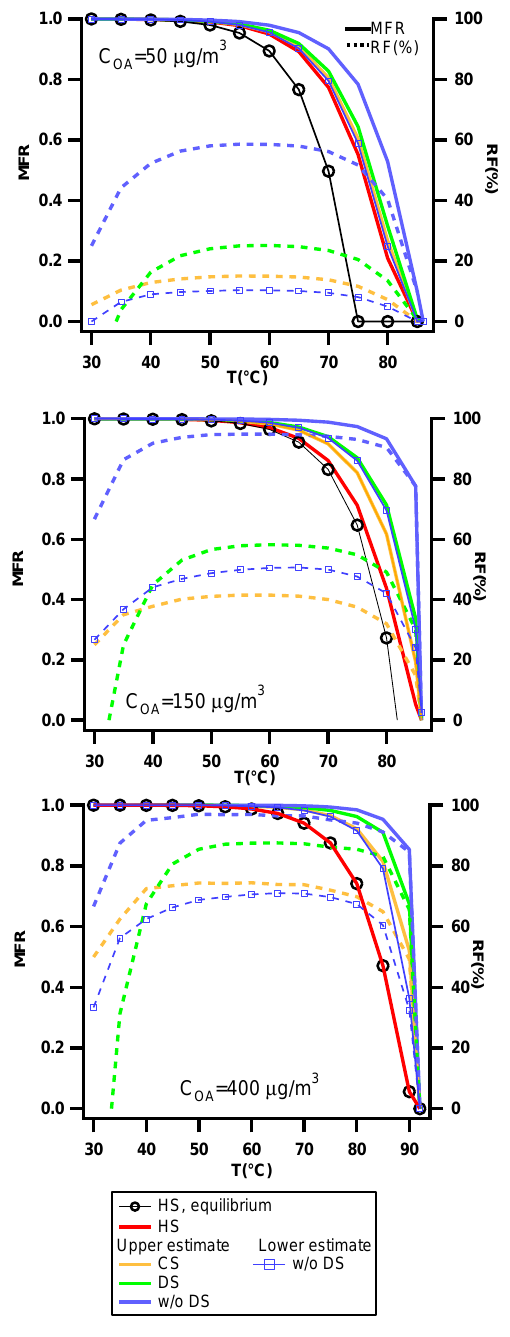
Fig. 3. Output thermograms and recondensation fraction for the heating section (HS), cooling section (CS), denuder section (DS) and equivalent configuration without denuder section (w/o DS) for different aerosol mass loadings. The results show that the efficiency of the denuder to hinder re-condensation decreases with increasing aerosol mass loading. Baseline case: C ∗ =0.01µgm 3 , d p =100nm, D i =5 × 10 − 6 cm 2 s − 1 and γ 0 =1. Upper estimate: upper es- timate for re-condensation (no mass transfer to walls); lower estimate: lower estimate for re-condensation (equilibrium wall